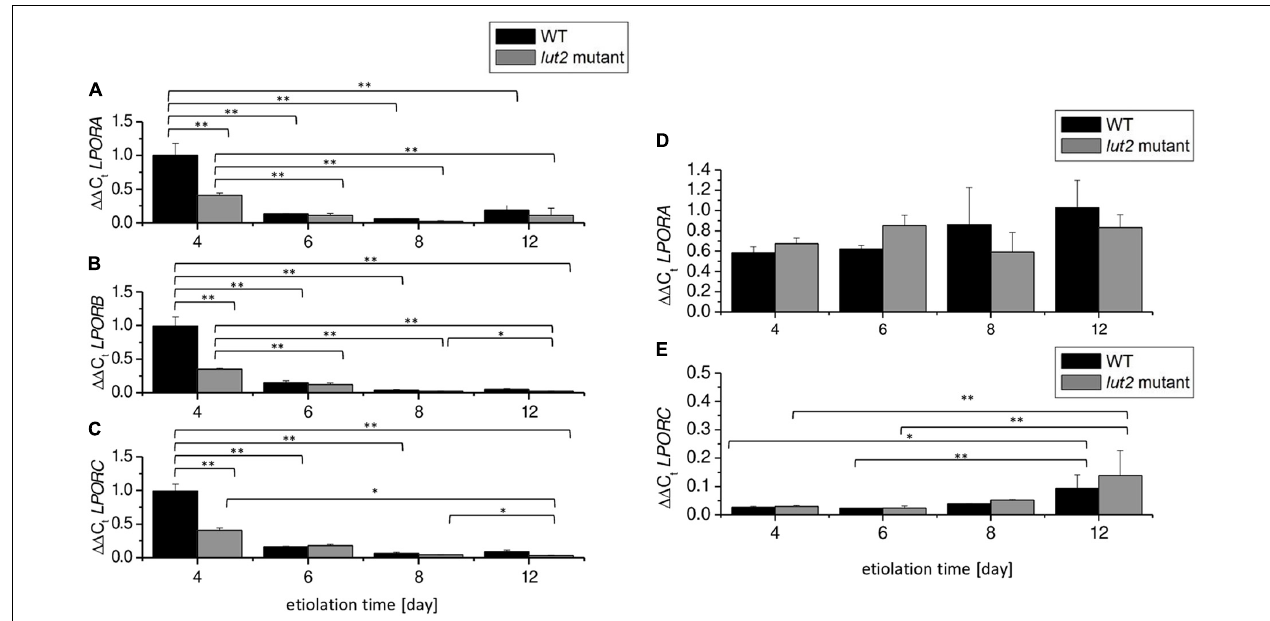
FIGURE 4 | Accumulation of LPOR transcripts. (A–C) (cid:49)(cid:49) C t values of LPORA , LPORB , and LPORC genes using the normalization factor obtained via GeNorm v3.4 from PDF , UBC , and SAND reference genes. (D,E) Re-calculation of expression of LPORA and LPORC in relation to the content of mRNA-encoding LPORB at a certain day of etiolation in WT and lut2 mutant . Bar heights represent arithmetic mean, while error bars represent SD; n = 3. Statistically significant differences from two-way ANOVA and post hoc Tukey test were indicated using ∗∗ p < 0.01 and ∗ p <